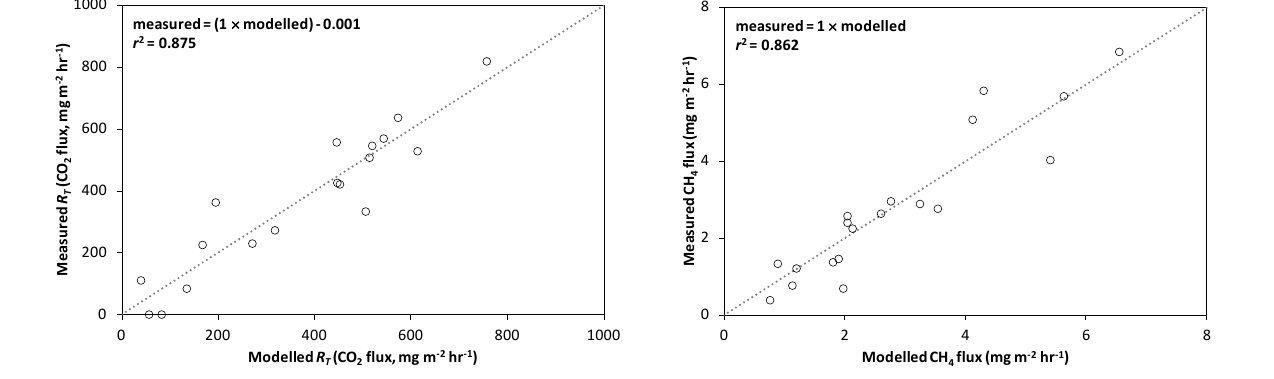
Figure 5. Measured vs modelled ecosystem respiration ( R ) for one of the collars at the North T Wales blanket peatland site. The dotted line is the 1:1 line.